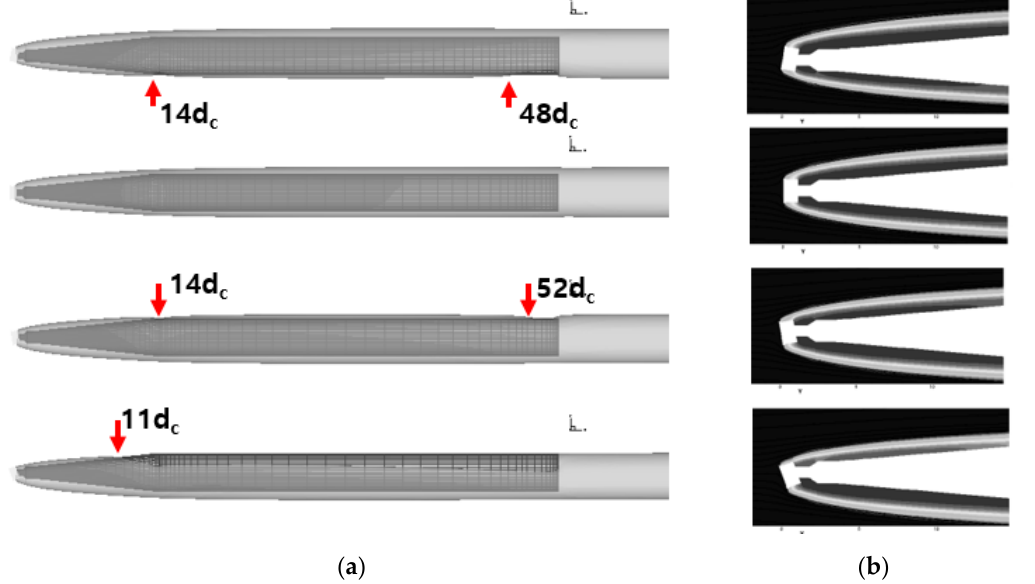
Figure 15. Real scale underwater body cavitation formation at various cavitator angles of attack (angle of a tt ack = − 10°, 0°, 10°, 20°): ( a ) cavity shape and point of collapse ( − 10°, 0°, 10°, 20°), and ( b ) cavitator angle of a tt ack ( − 10°, 0°, 10°, 20°).